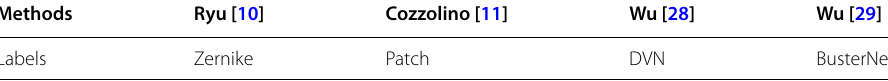
Table 8 Labels of different existing methods